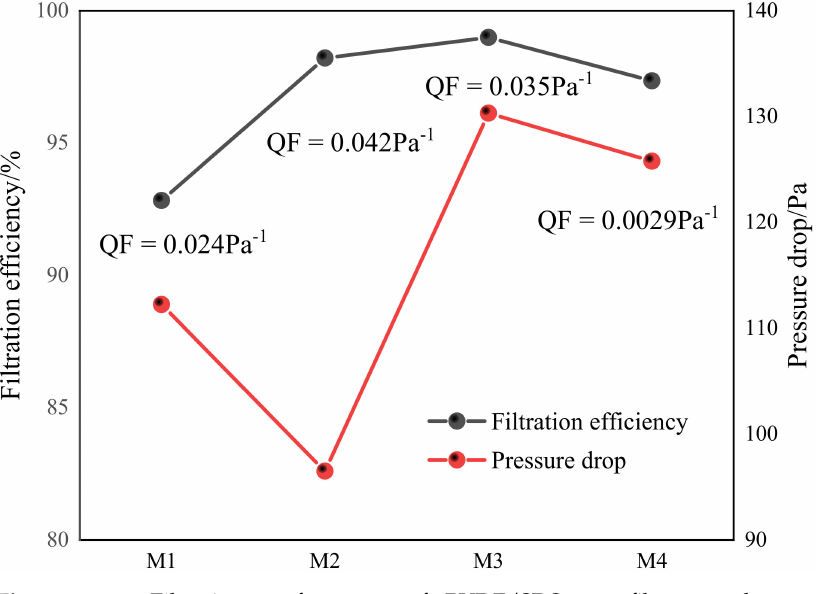
Figure 11. Filtration performance of PVDF/SDS nanofiber membranes with different SDS